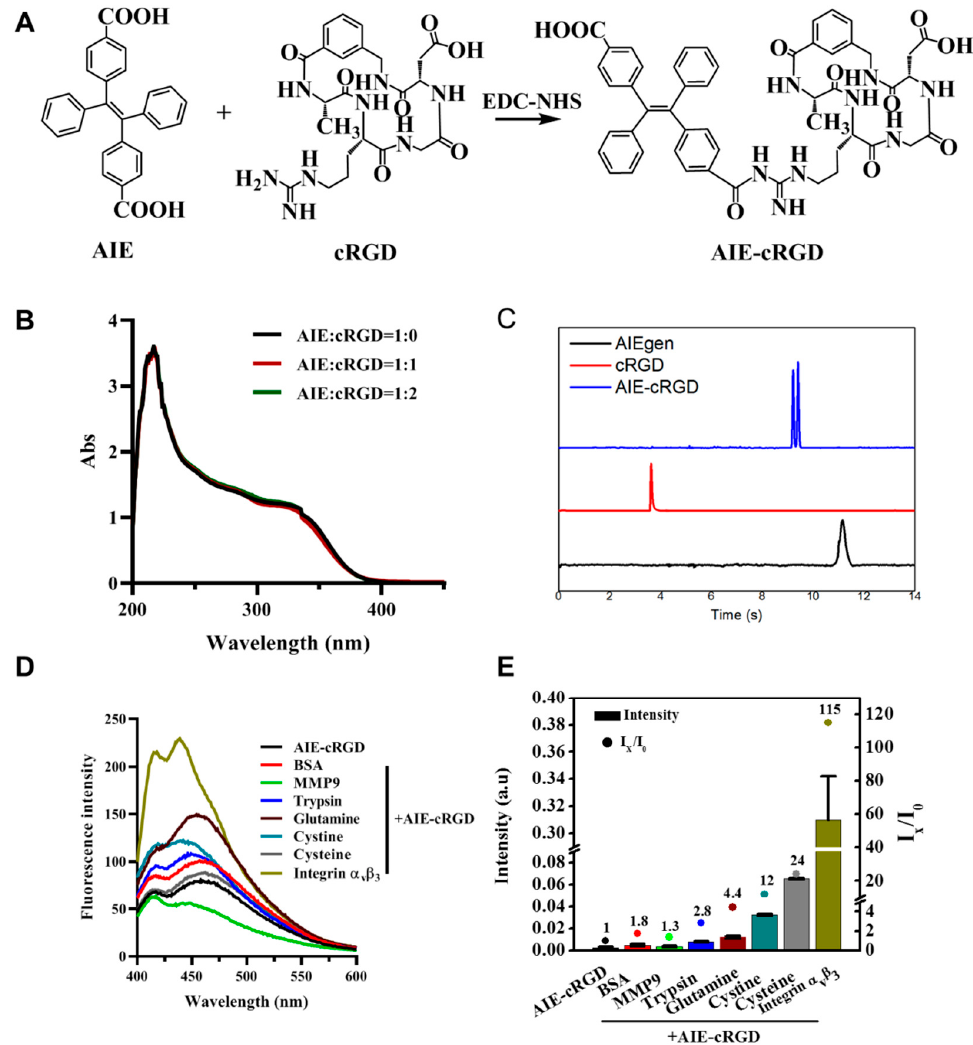
Figure 1. Synthesis and characterization of AIE–cRGD. ( A ) Synthesis scheme of AIE–cRGD. ( B ) UV spectra of different proportion of AIE with cRGD. AIE/cRGD = 1/0 (blank line), AIE/cRGD = 1/1 (red line), AIE/cRGD = 1/2 (green line), respectively. ( C ) Capillary electrophoresis characterization of AIE–cRGD, the blue line means AIE–cRGD, the red line means cRGD, and the black means AIE molecular. ( D ) The fluorescence intensity of AIE–cRGD, when Ex= 365 nm with various target biomolecules (n (AIE–cRGD)/n (biomolecules) = 1:1). ( E ) The intensity of ultraviolet absorption of AIE–cRGD at 230 nm with various target biomolecules.